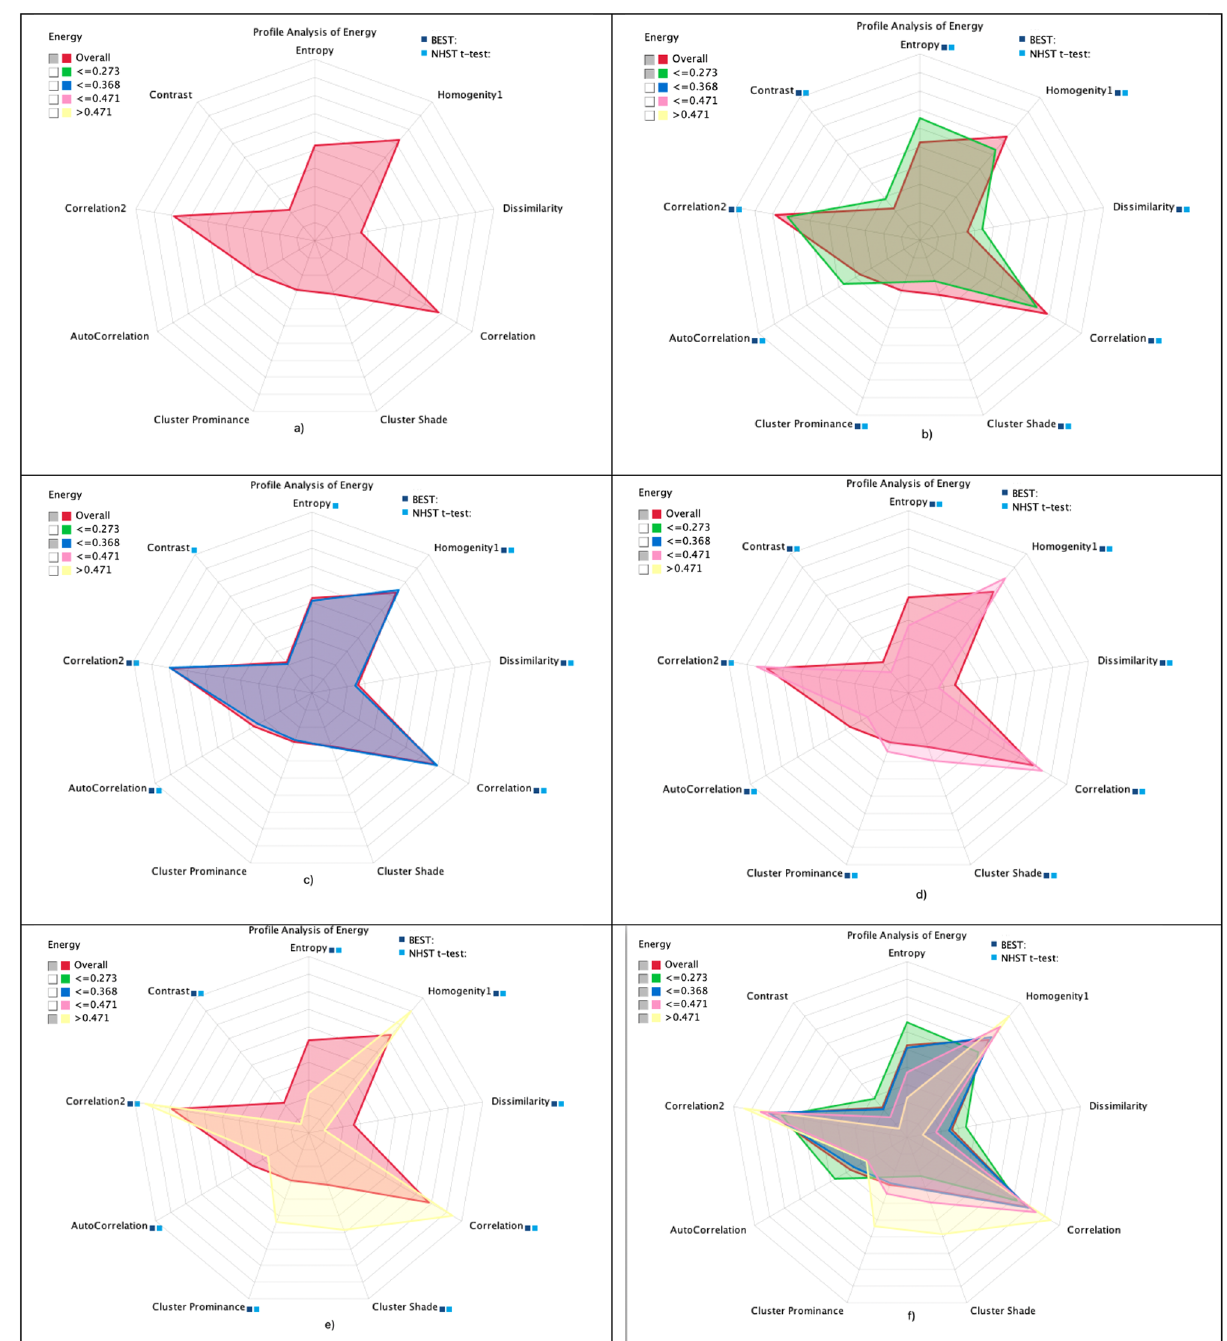
Figure 6. Association graph of segment profile analysis of energy node with other extracted GLCM features using radar chart graph at different selected states ( a ) overall and overall with selected states ( b ) ≤